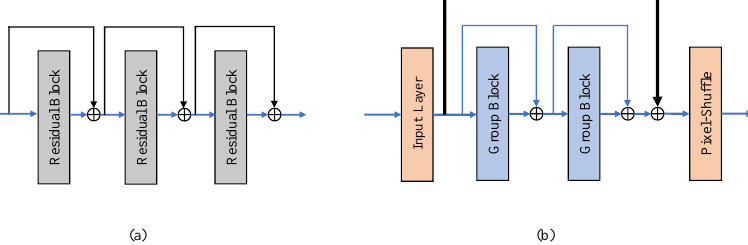
Figure 2. Deep Residual Block and Feature Fusion Connection. ( a ) The Group Block. ( b ) The Deep Residual Block. In the Group Block, the black lines represents Group Feature Connection. In the Deep Residual Block, the blue line and thick black line represent Deep Redisual Feature